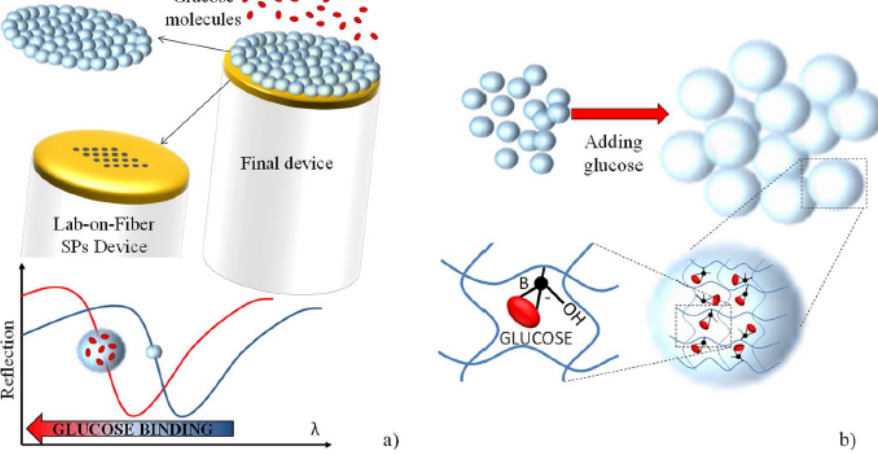
Figure 35. ( a ) Schematic of the developed device based on the combination of microgels (MGs) and LOF Technology; ( b ) Schematic view of the glucose-binding event inside the MGs network. Reprinted with permission of [97].